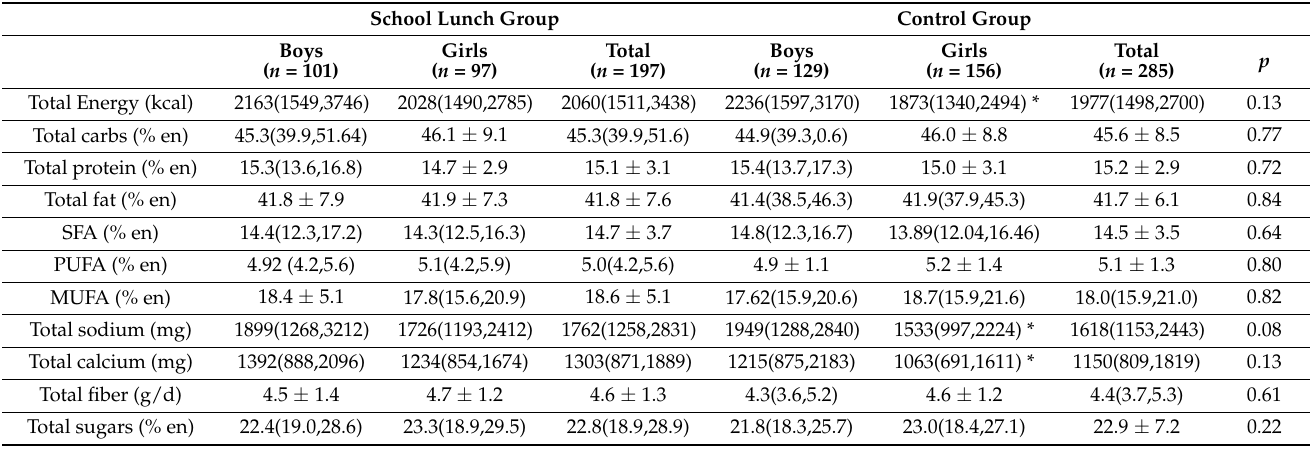
Table 3. Daily energy, macronutrients, sodium, calcium, fibers, and sugars intake of children participants, according to population group and